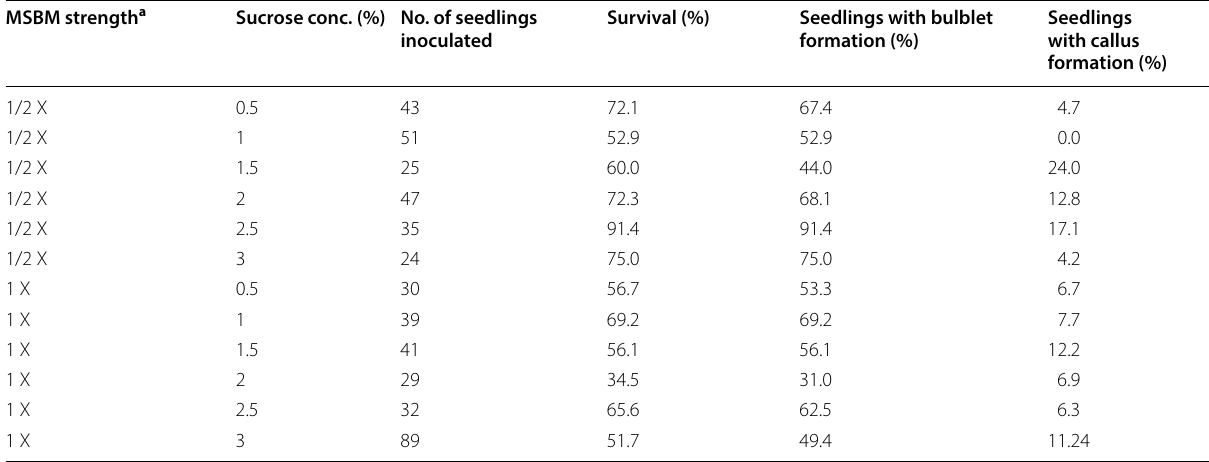
Table 3 Effects of different salt and sucrose concentrations on growth parameters of 1 month old in vitro seedlings of F.